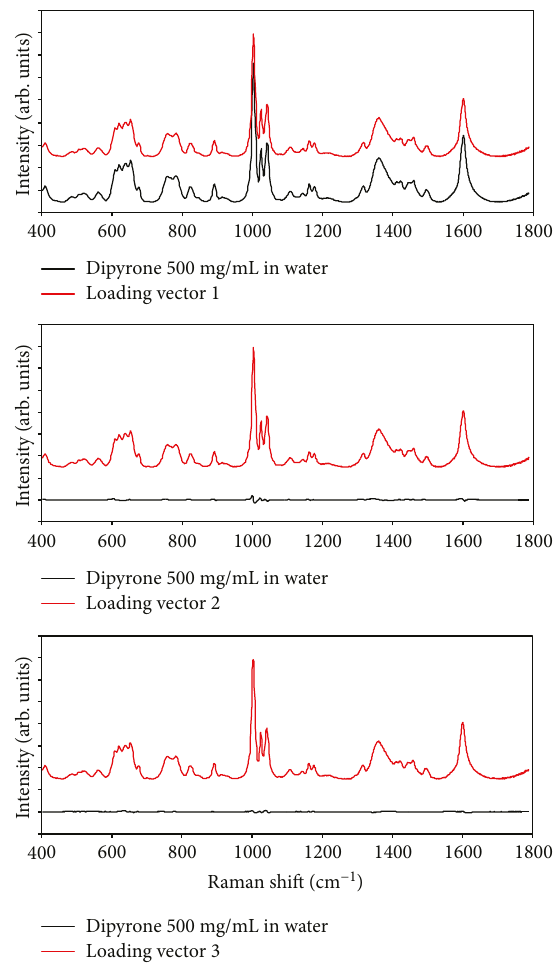
Figure 3: Raman spectra of a solution of 500mg/mL of dipyrone diluted in distilled water (100% dilution) and the reference commercial solution of dipyrone 500mg/mL. Table 1 presents the labeled peaks in the reference solution that are related to dipyrone and their assignments. Inner plot: metamizole chemical formula {[(1,5-dimethyl-3-oxo-2-phenylpyrazol-4-yl)-methylamino] methanesulfonic acid sodium